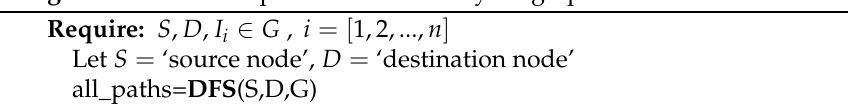
Algorithm 1: Find all paths in directed acyclic